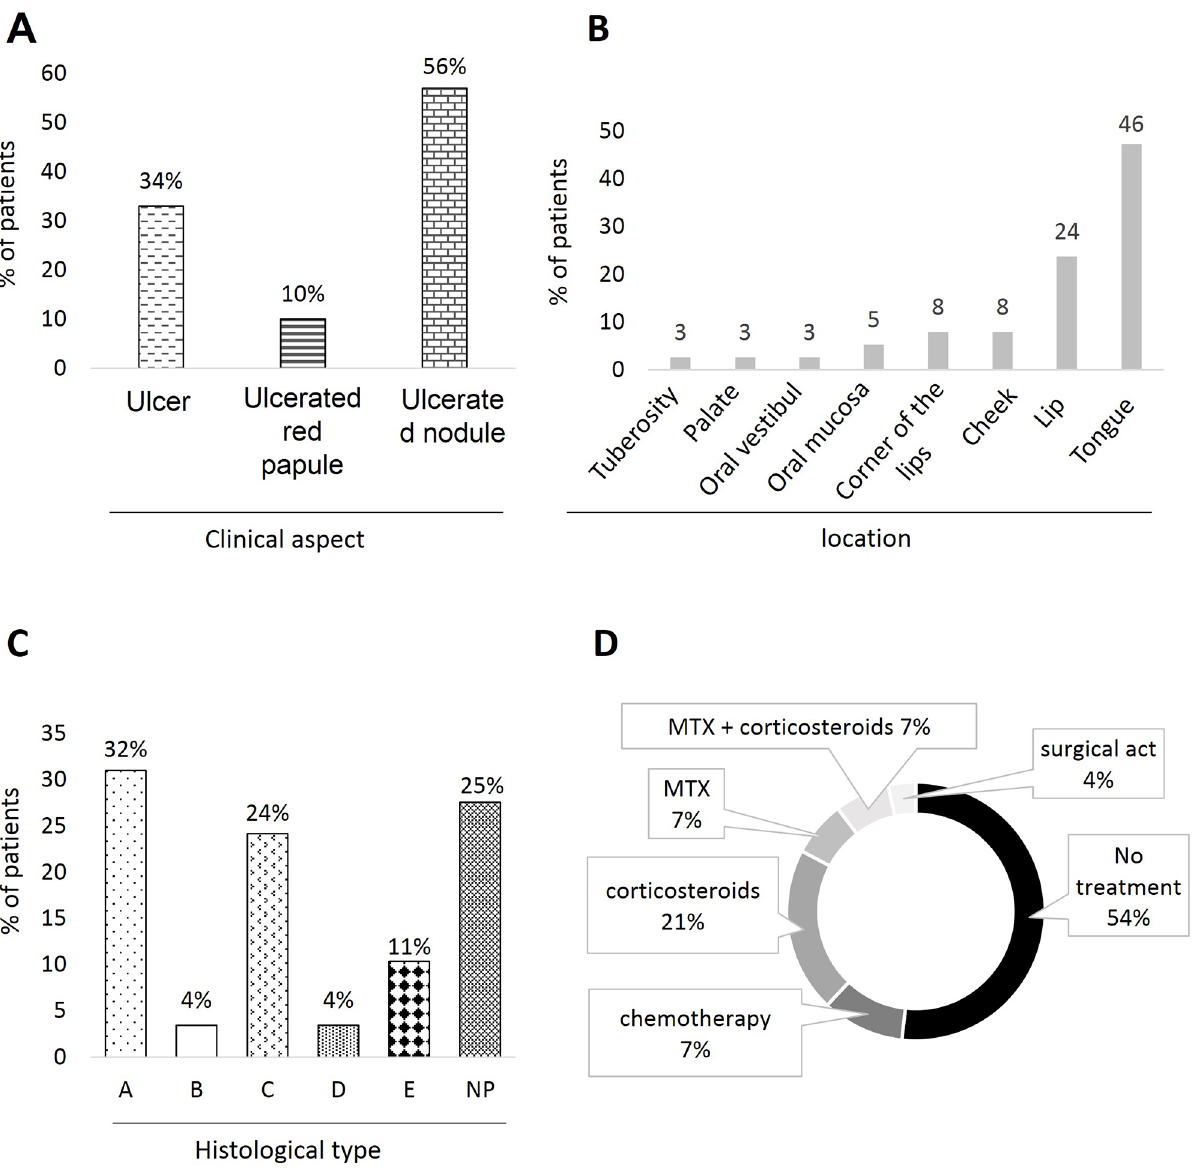
Fig. 3. Clinical and histological characteristics of oral LyP cases reported in the literature. (A) lesion type; (B) oral site concerned; (C) histological sub-type; (D) therapeutic